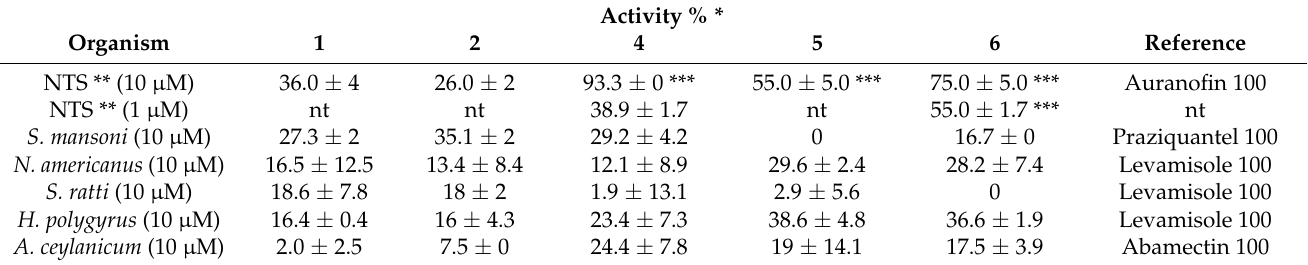
Table 2. In vitro anthelmintic activity of compounds 1 – 6 against parasitic helminths. Activity % *